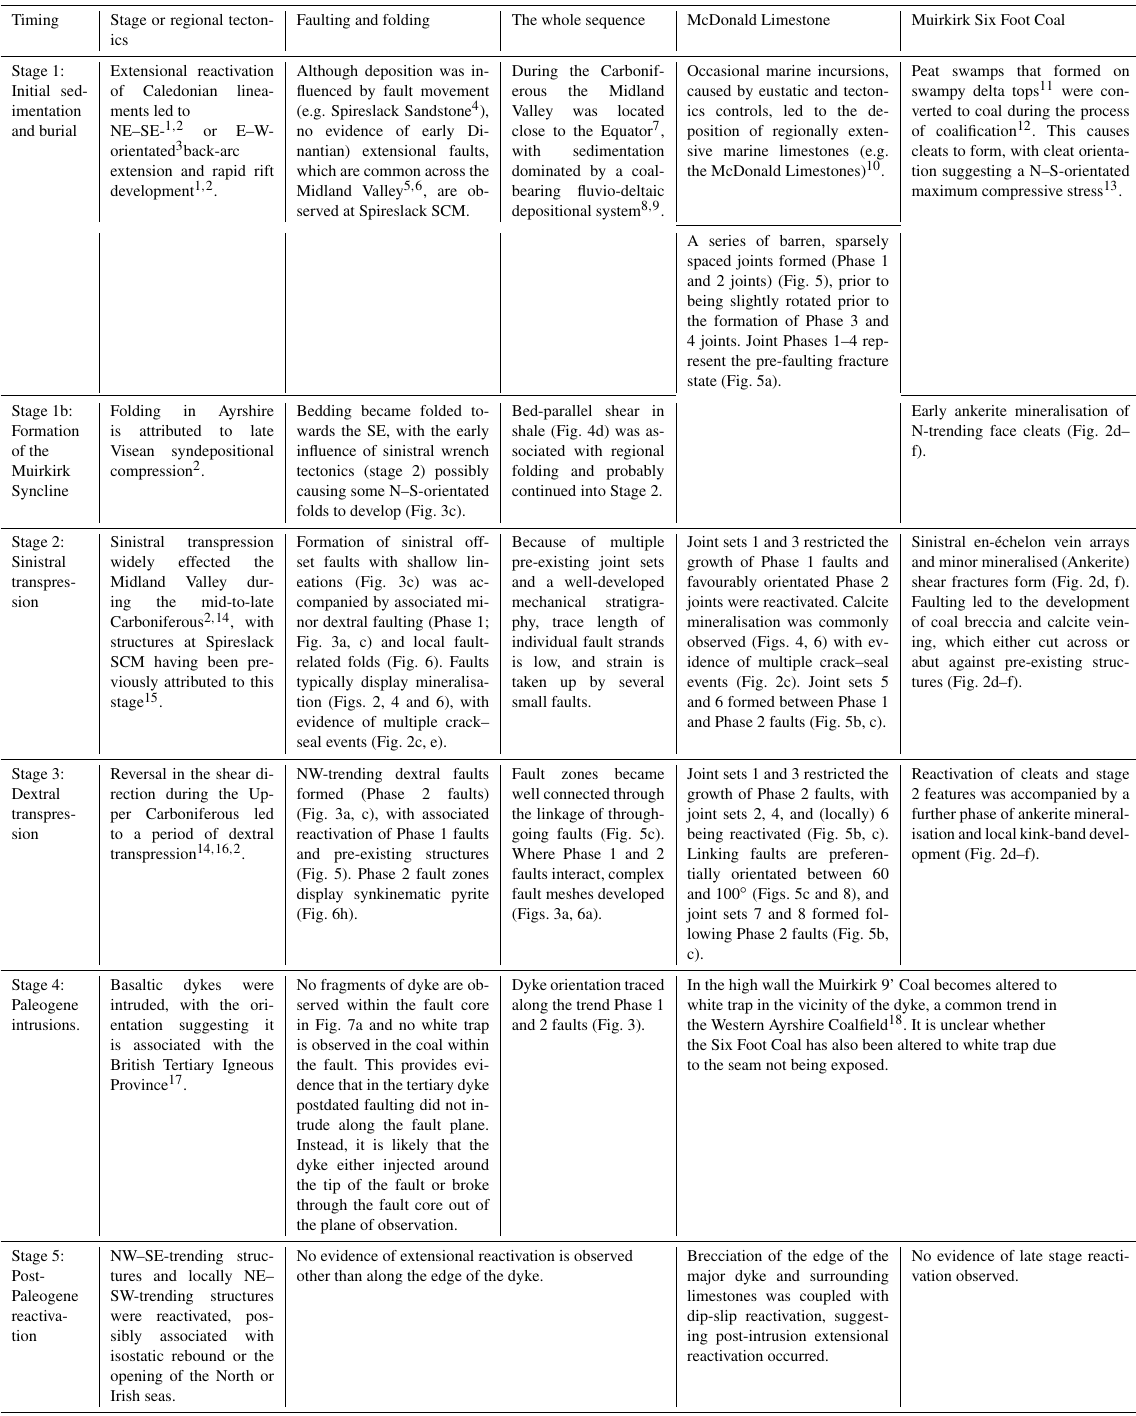
Table 4. Summary of the structural features observed at Spireslack SCM. References in the table are as follows: (1) Leeder (1982); (2) Under- hill et al. (2008); (3) Haszeldine (1984); (4) Ellen et al. (2019); (5) Coward, (1993); (6) Anderson (1951); (7) Soper et al. (1992); (8) Browne et al. (1999); (9) Read et al. (2002); (10) George, (1978); (11) Thomas (2013); (12) O’Keefe et al. (2013); (13) Rippon et al. (2006); (14) Ritchie et al. (2003); (15) Leslie et al. (2016); (16) Caldwell and Young (2013); (17) Emeleus and Gyopari (1992); and (18) Mykura